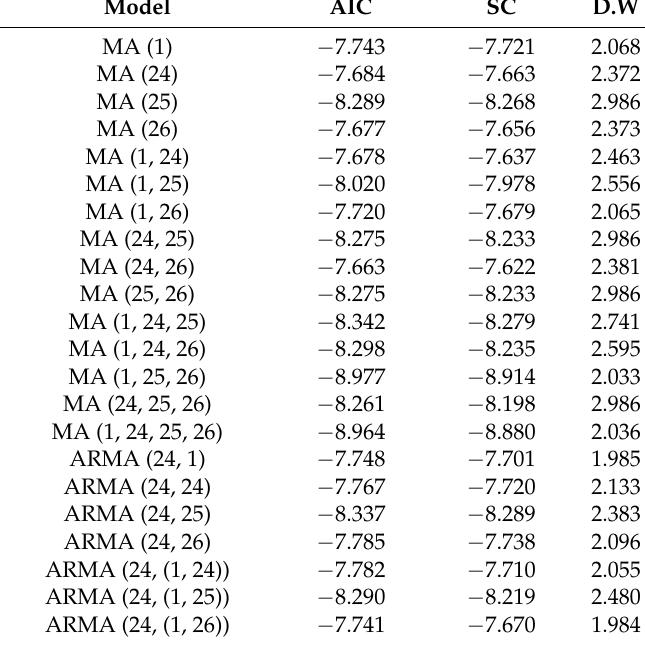
Table 11. Accuracy test of ARMA (p,